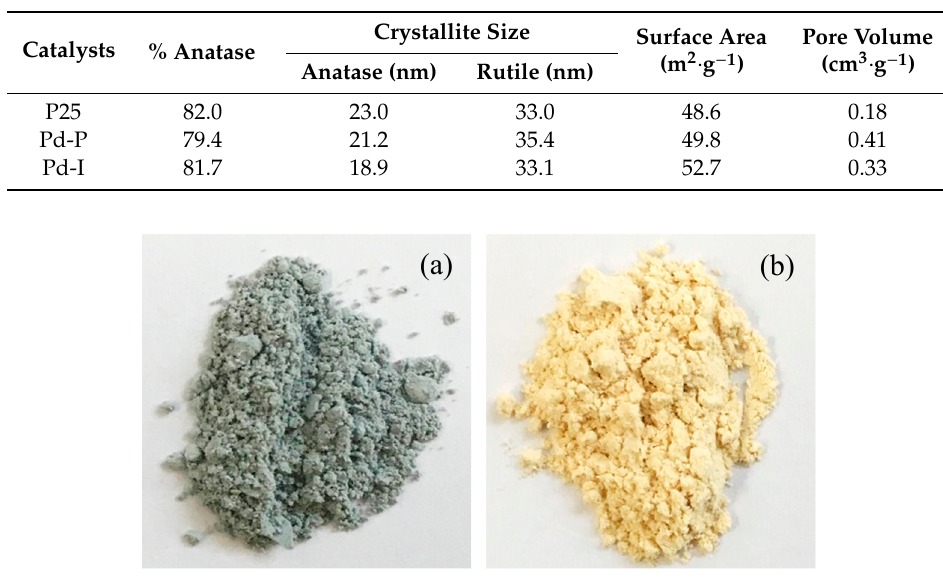
Table 1. Main characteristics of the catalysts.